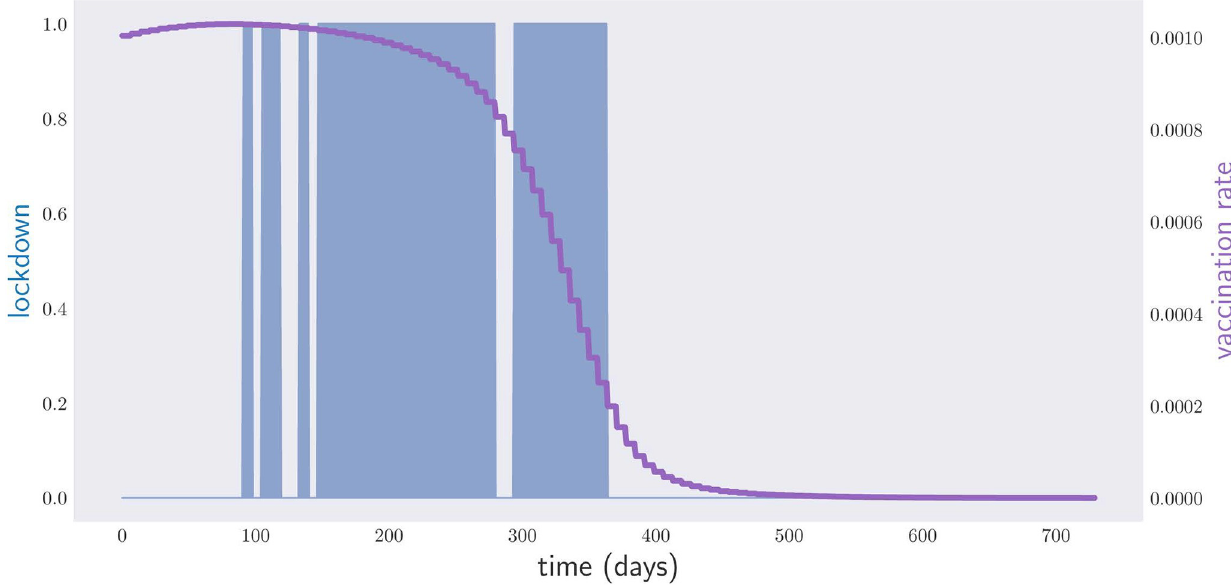
Fig 8. Weekly lockdown times (blue) and vaccination rates (magenta) for a period of two years.